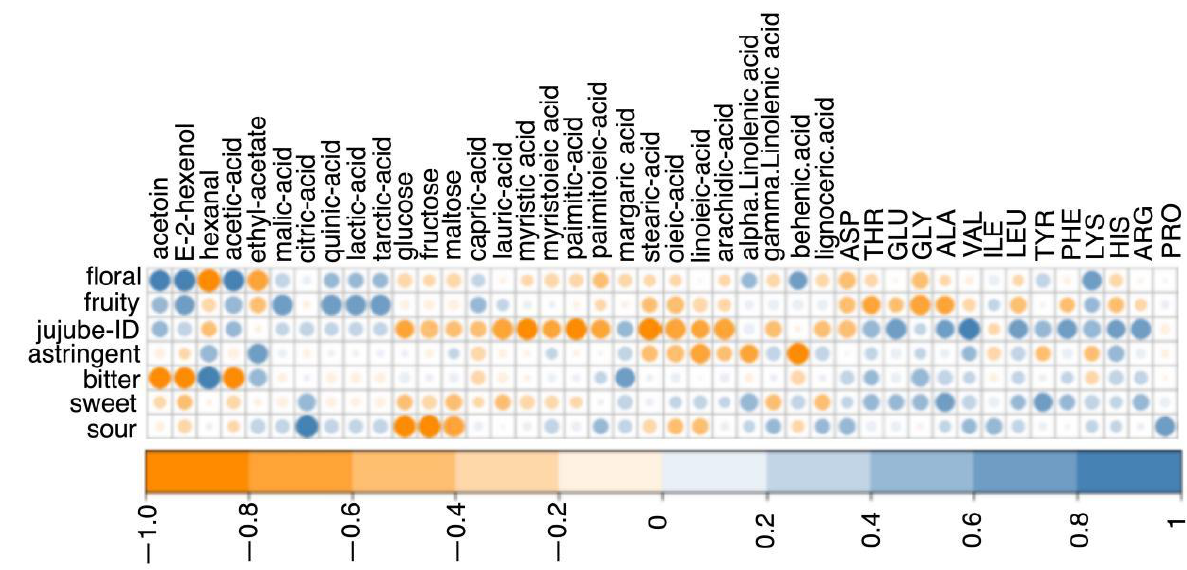
Figure 6. Correlation analysis among sensory attributes and fatty acids, amino acids, organic acids, sugars and VOCs (VIP score > 1) of the six red jujube cultivars from Xinjiang Province, China.